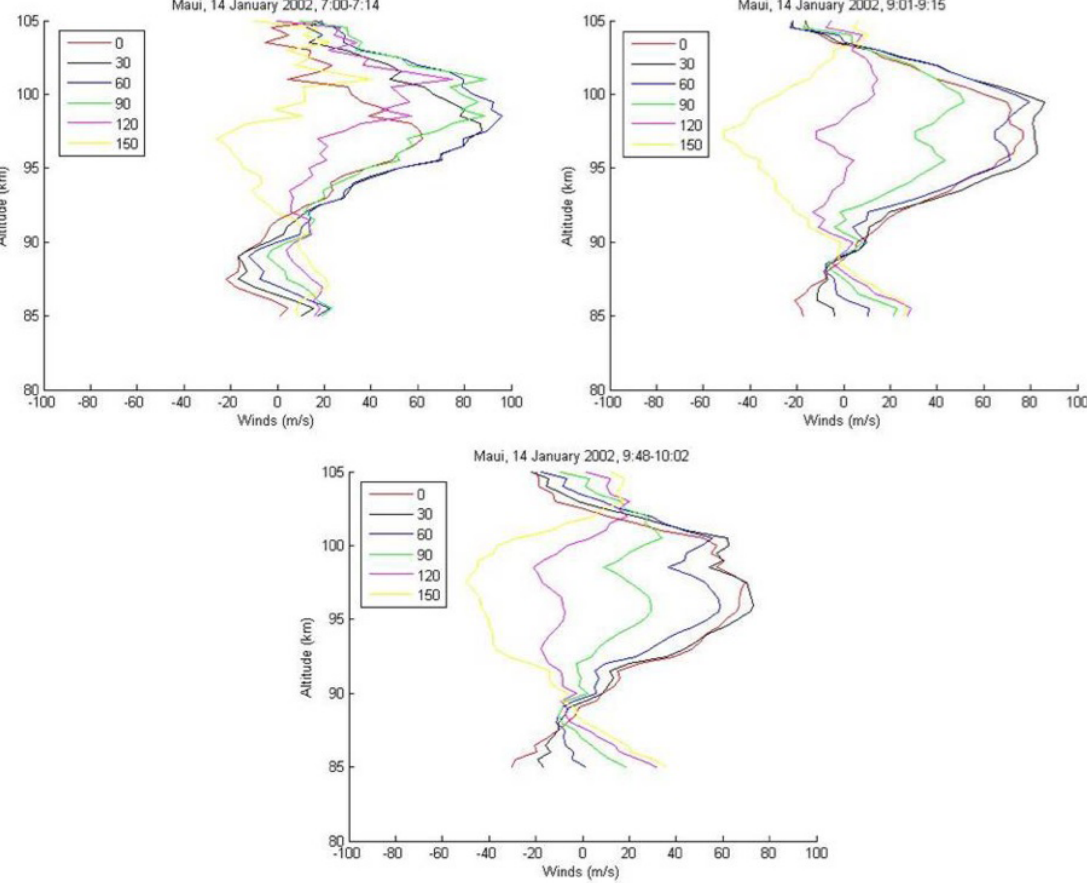
Fig. 5. Wind profiles showing shears and and the inflection point for varying vertical orientations at different stages of the observing period for 14 Janurary 2002. The legend refers to the degrees of the direction for the corresponding profile.